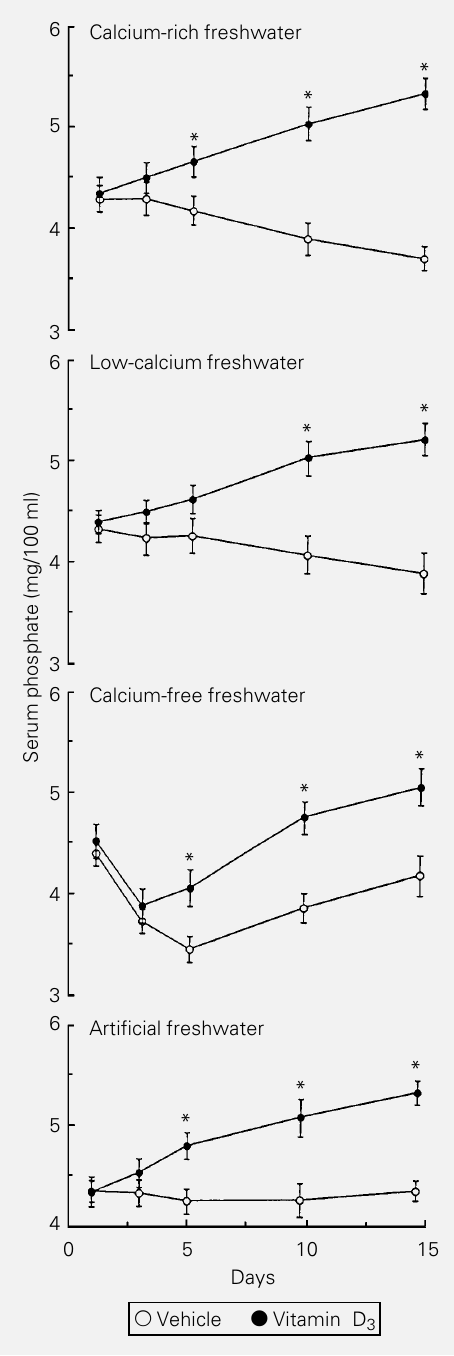
Figure 2 - Changes in serum phosphate levels of A. cuchia kept in artificial freshwater, cal- cium-free freshwater, low-cal- cium freshwater or calcium-rich freshwater and treated with ve- hicle or vitamin D 3 . Each value represents the mean ± SEM for six specimens. Asterisk indi- cates significant differences (P<0.05) compared to the ve- hicle-injected group (Student t -